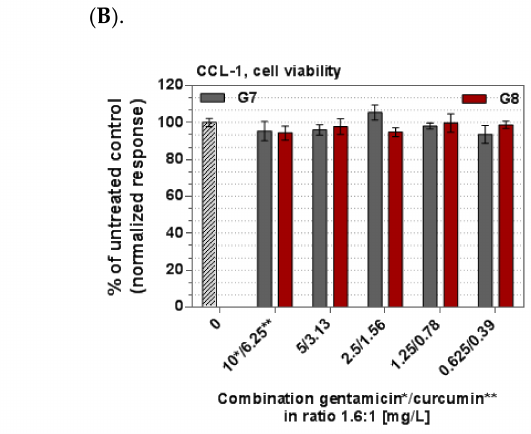
Figure 10. Viability of CCL-1 cells. Legend: ( A ). After exposure to solution containing empty niosomes (30 µ mol/mL total lipid). ( B ). After exposure to hybrid in situ niosomal gels based on simultaneously loaded Curc/GS niosomes.